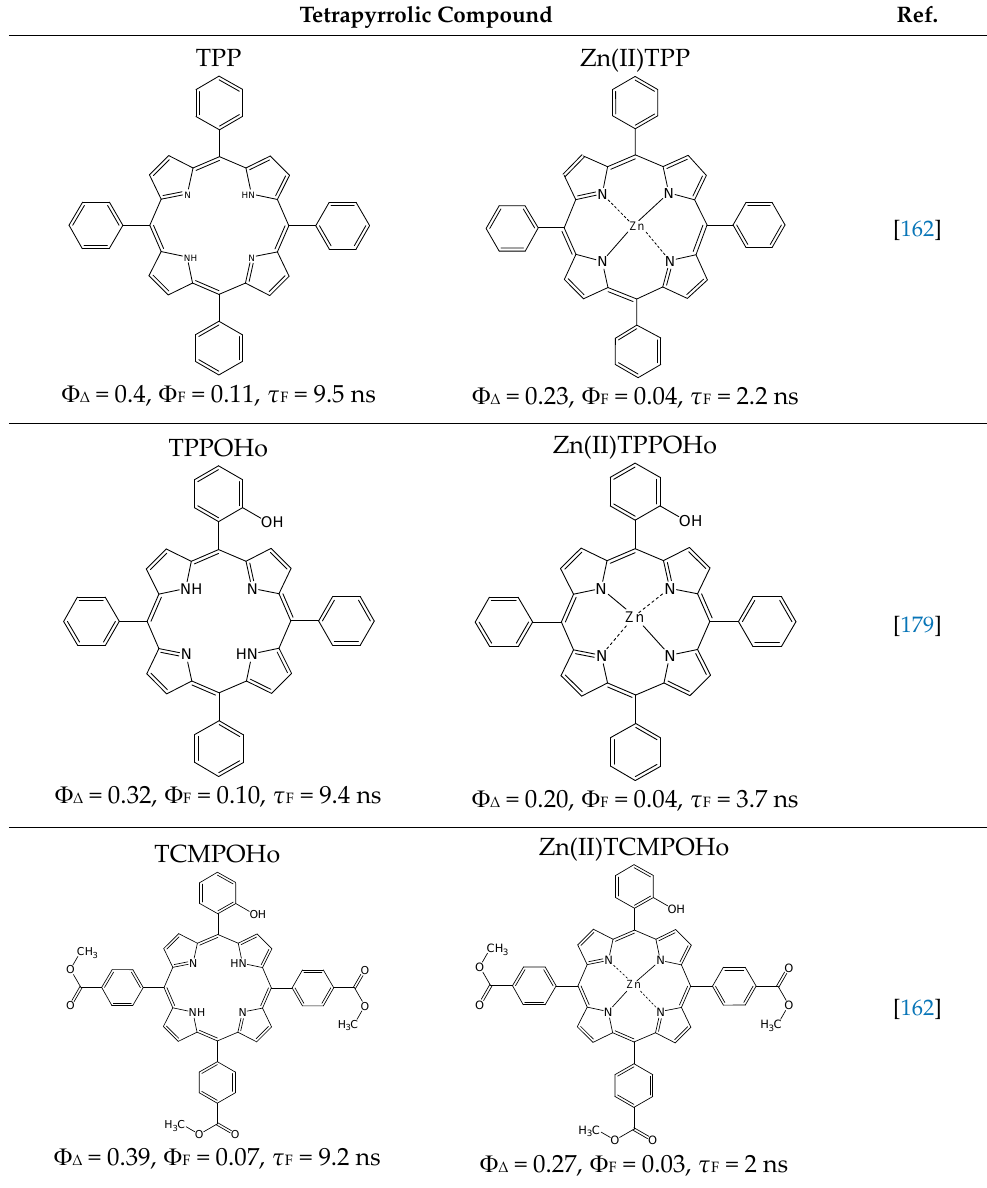
Table 3. Singlet oxygen formation quantum yield ( Φ ∆ ), fluorescence emission quantum yield ( Φ F ), and fluorescence lifetime ( τ F ) for a series of tetrapyrrolic compounds (solvent CHCl 3 , except *marked structures were CH 3 OH was used).